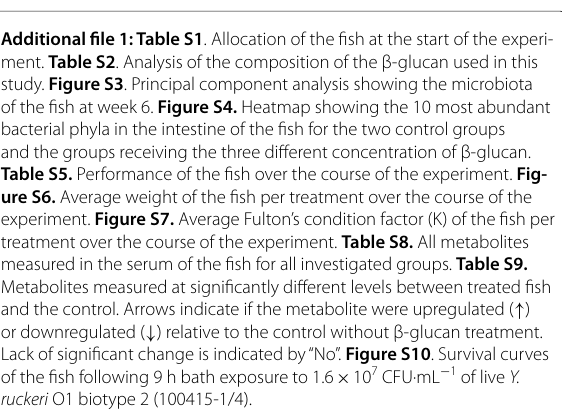
study. Figure S3 . Principal component analysis showing the microbiota of the fish at week 6. Figure S4. Heatmap showing the 10 most abundant bacterial phyla in the intestine of the fish for the two control groups and the groups receiving the three different concentration of β‑glucan. Table S5. Performance of the fish over the course of the experiment. Fig- ure S6. Average weight of the fish per treatment over the course of the experiment. Figure S7. Average Fulton’s condition factor (K) of the fish per treatment over the course of the experiment. Table S8. All metabolites measured in the serum of the fish for all investigated groups. Table S9. Metabolites measured at significantly different levels between treated fish and the control. Arrows indicate if the metabolite were upregulated ( ) ↑ or downregulated ( ) relative to the control without β‑glucan treatment. ↓ Lack of significant change is indicated by “No”. Figure S10 . Survival curves of the fish following 9 h bath exposure to 1.6 10 7 CFU∙mL − 1 of live Y. × ruckeri O1 biotype 2